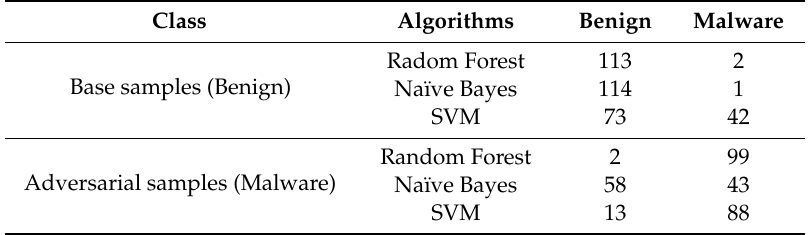
Table 8. The detection performance of machine-learning algorithms with the full feature model. Algorithm Class Precision Recall F-Measure Benign 0.997 Random Forest Naïve Bayes